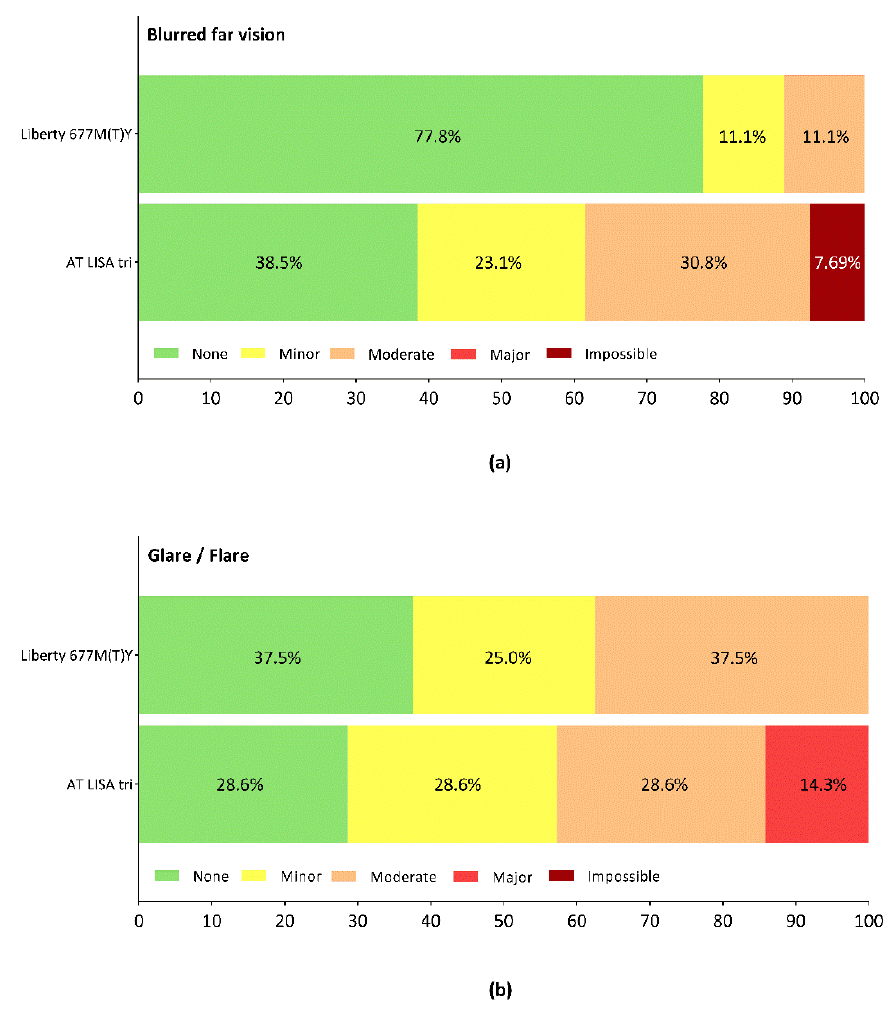
Figure 6. Distribution of responses given by the patients regarding difficulties caused by ( a ) blurred far vision, and ( b ) glare/flare. Subjective assessment was performed using a modified visual function questionnaire completed at 12 months postoperatively.